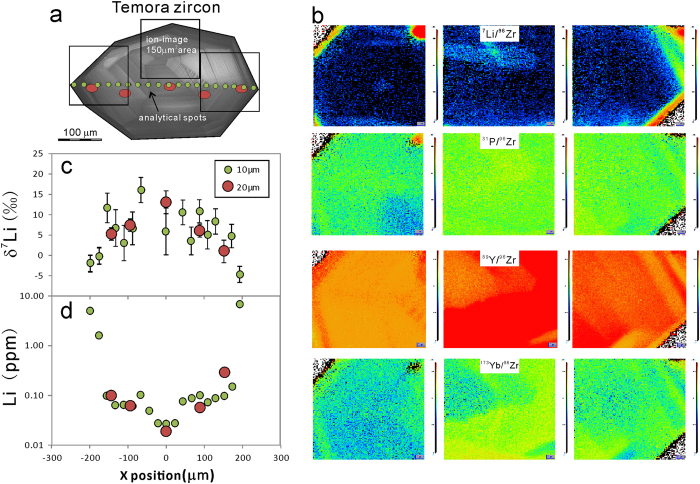
(a) The CL image and analytical spots of the Temora zircon. (b) ion image of Li, P, Y, and Yb. (c) δ7Li profile through zircon. (d) [Li] profile through zircon.